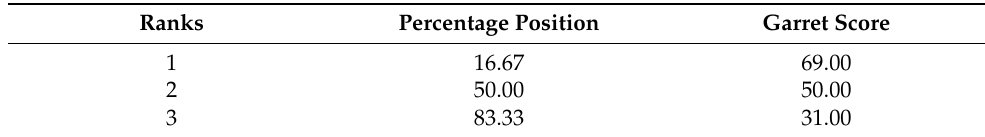
Table 7. Percentage position and Garrett value for rank 1 to